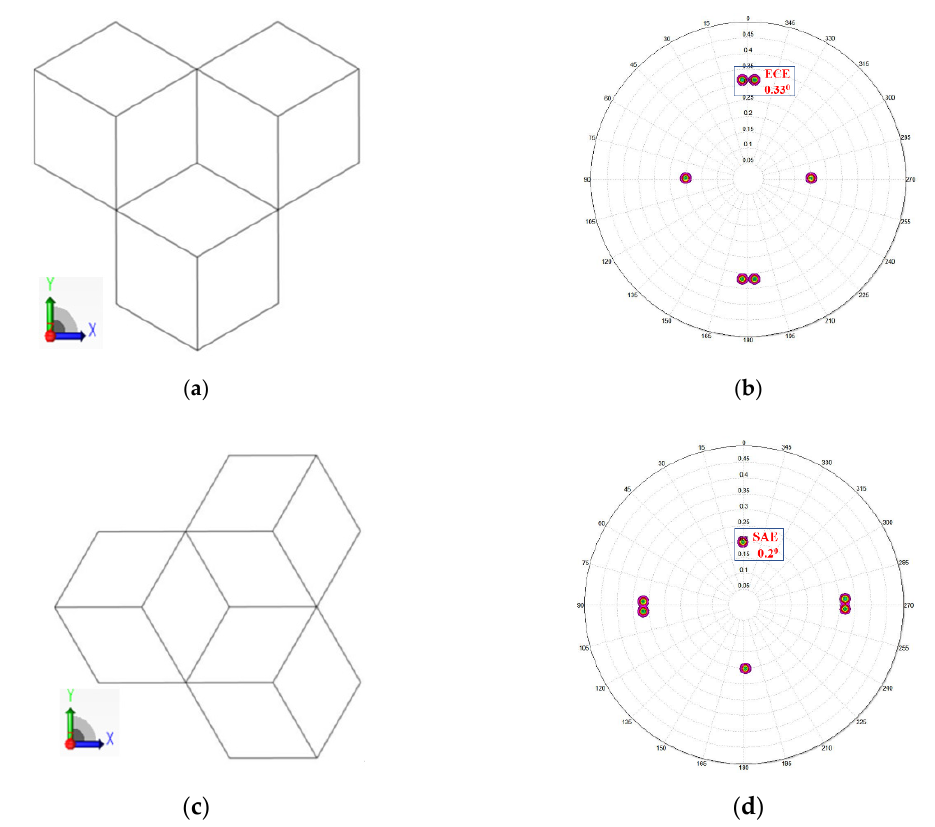
Figure 5. ( a ) The orientation of the corner cube reflector for EU Economic Commission for Europe (ECE) regulations. ( b ) The reflected intensity distribution accomplished by the corner cube reflector for ECE regulations. ( c ) The orientation of the corner cube reflector for US Society of Automotive Engineers (SAE) regulation, which is the 45 ° rotated corner cube reflector for ECE regulations. ( d ) The reflected intensity distribution accomplished by the corner cube reflector for SAE regulations.